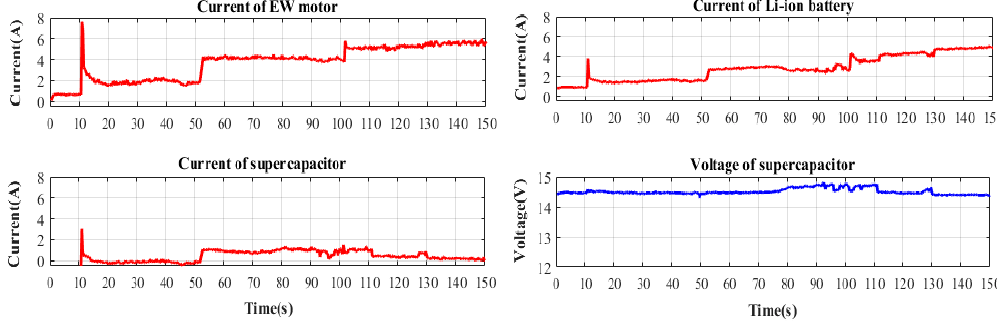
Figure 14. Experimental results of the passive hybrid energy storage system (P-HESS).